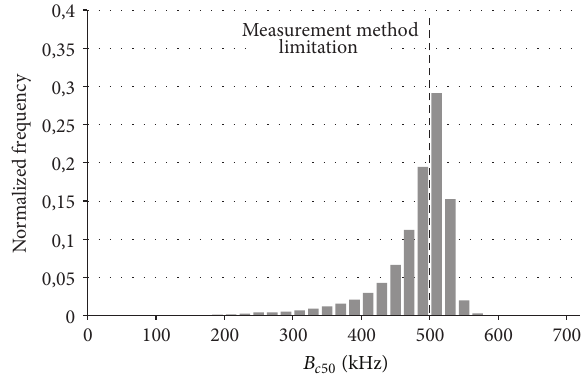
Figure 18: Histogram of coherence bandwidth values estimated from rms delay spread for correlation level 0.5 in flat